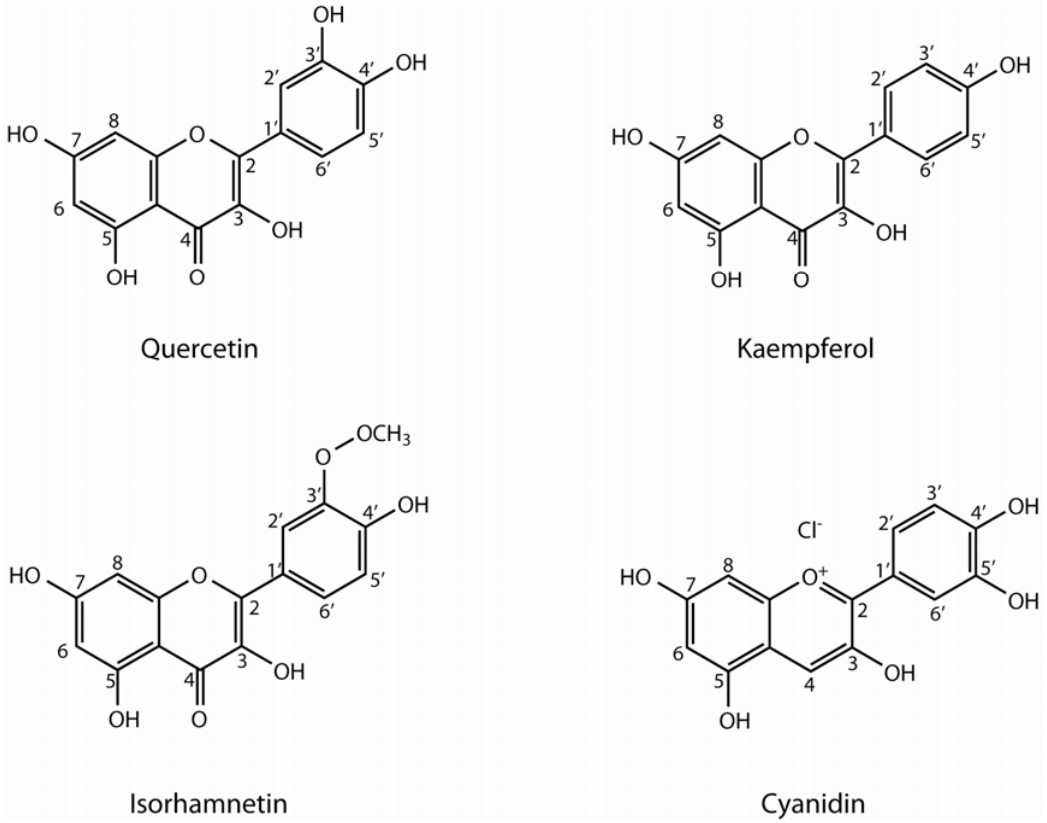
Figure 1. Flavonoid aglycones found in vegetable Brassica